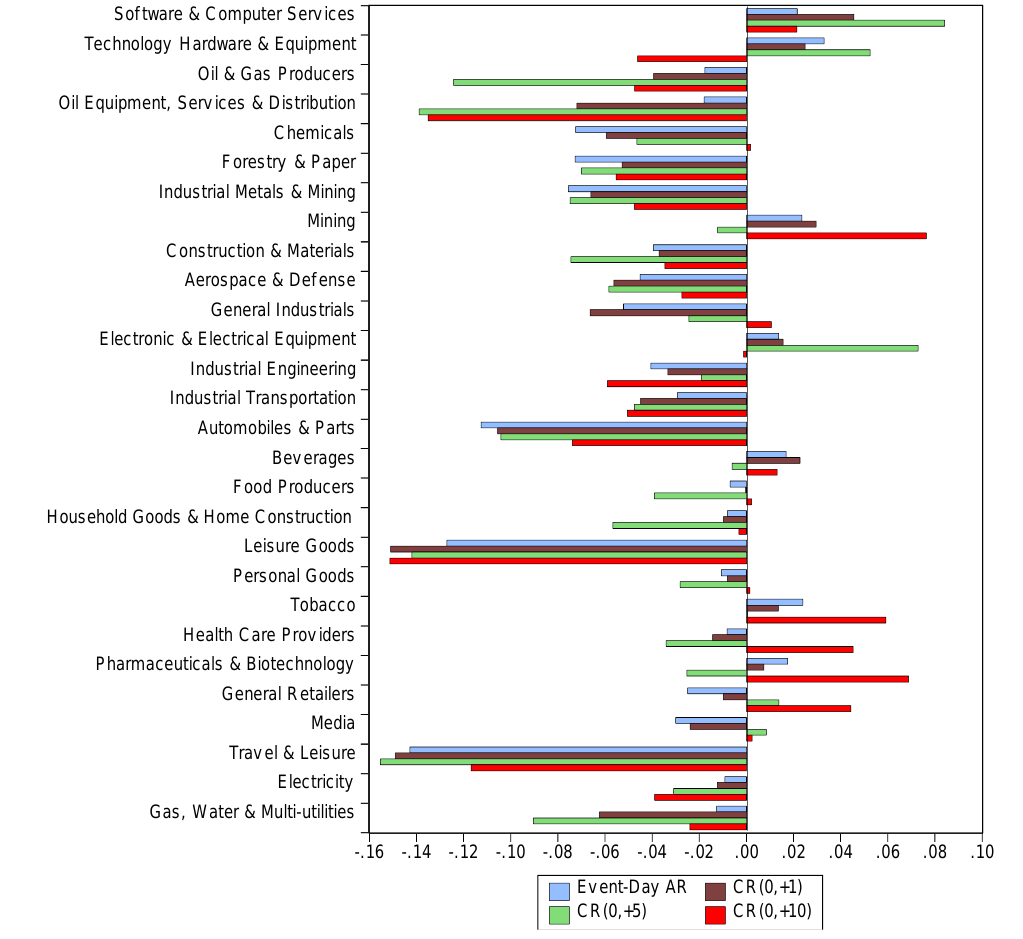
Figure 2: ARs and CRs of U.S. non-financial sectors in response to the September 11 th attacks. Structural Break